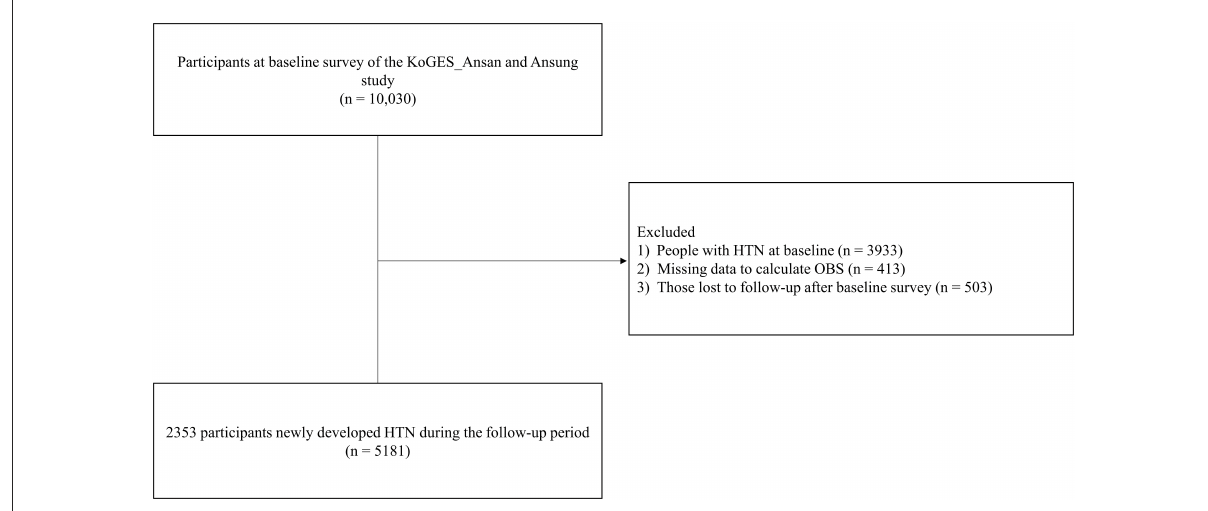
FIGURE1 Flowchart of the study population. KoGES, korean genome and epidemiology study; HTN, hypertension; OBS, oxidative balance score.